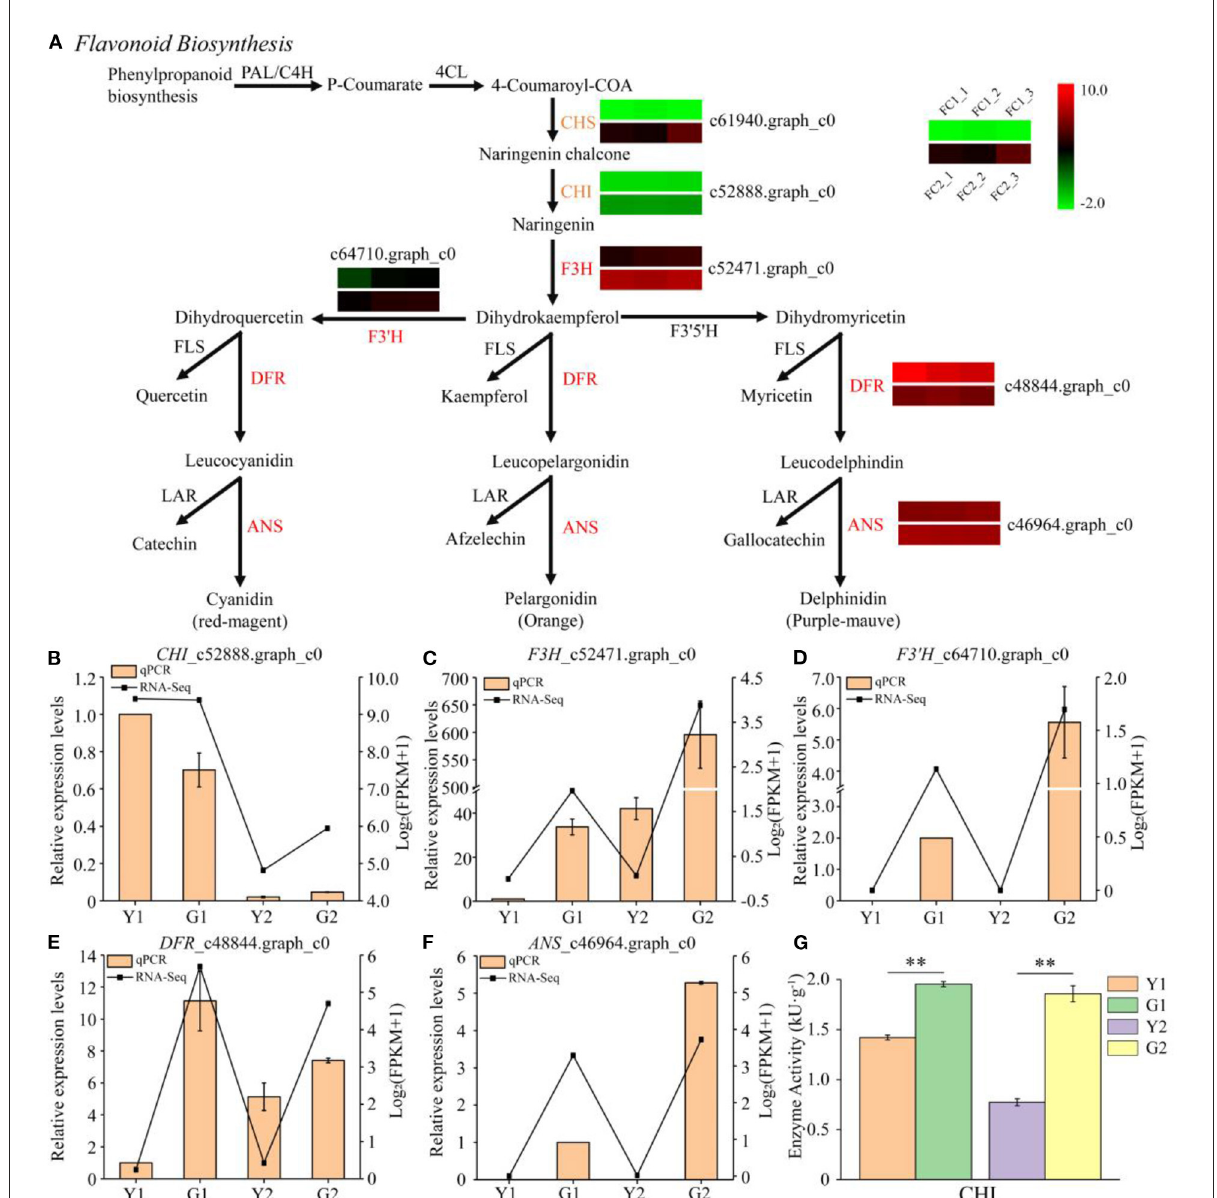
FIGURE6 Transcriptional profiling of DEGs involved in flavonoid biosynthesis. (A) DEGs involved in flavonoid biosynthesis. PAL phenylalanine ammonia-lyase, 4CL 4-coumarate CoA ligase, CHS chalcone synthase, CHI chalcone isomerase, F3H flavanone 3-hydroxylase, F3 ′ 5 ′ H flavonoid 3 ′ 5 ′ -hydroxylase, F3 ′ H flavonoid 3 ′ -hydroxylase, DFR dihydroflavonol 4-reductase, ANS anthocyanidin synthase, LAR leucocyanidin reductase, FLS flavonol synthase. (B–F) Relative expression of five selected genes validated by qPCR. Error bars indicate standard deviation (SD) of three technical repeats. (G) Determination of CHI enzyme activity. Data is presented as the mean ± standard deviation. Statistical analyses were performed by student’s t -test, ** p < 0.01.